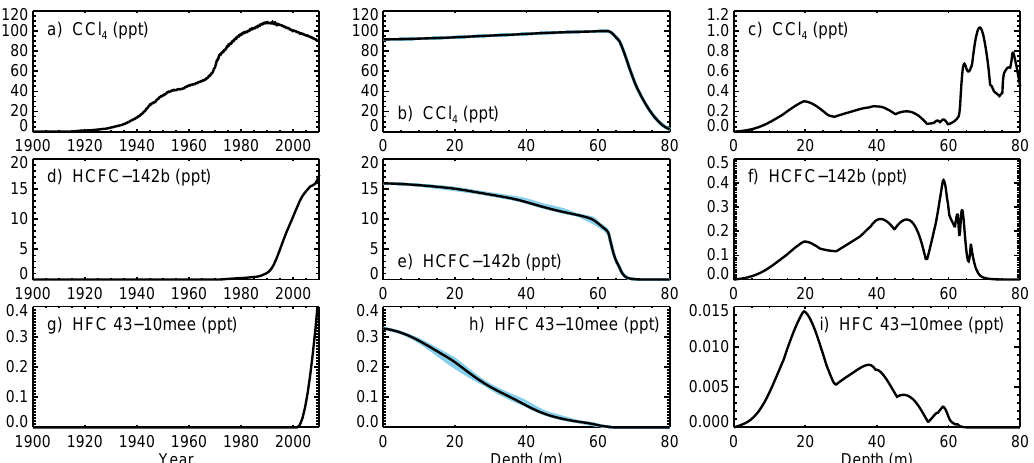
Fig. 8. The left column shows Northern Hemisphere atmospheric histories of CCl 4 , HCFC-142b and HFC-43-10mee (CCl 4 from Martinerie et al. (2009) and HCFC-142b and HFC-43-10mee are Representative Concentration Pathways (Meinshausen et al., 2011) with the RCP3-PD (2.6) from the IMAGE model after 2005). The middle column shows modelled firn profiles at NEEM for these tracers, where the black lines show the best case and the blue lines show 19 representative solutions for 8 N < 0 . 78. The right column shows half the spread of representative solutions for this